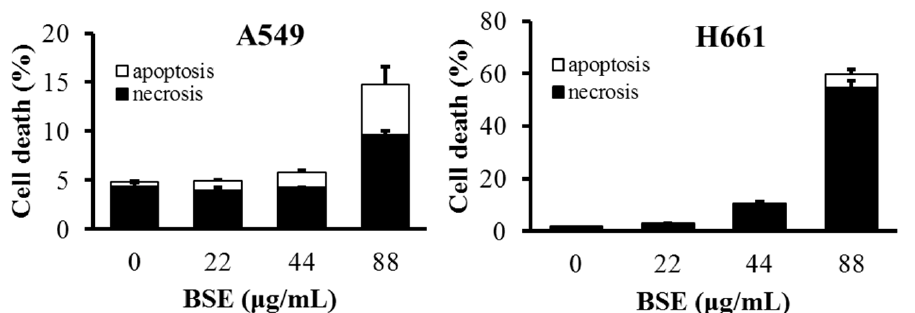
Figure 4. The ratio of apoptosis and necrosis induced by different concentrations of BSE on A549 and H661 cells for 24 h treatment.